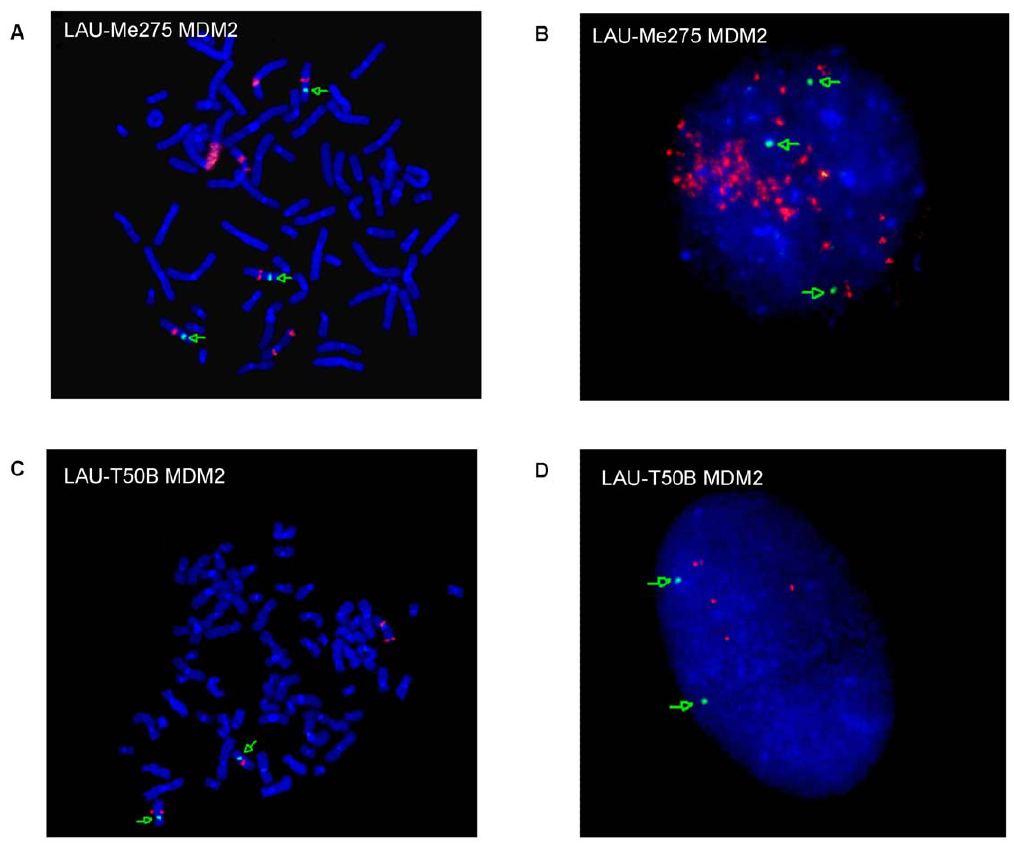
Figure 3. Determination of MDM2 copy number by FISH. The MDM2 gene was assayed in two melanoma samples (LAU-Me275 and LAU-T50B) derived from the same patient. Panels A and C show a metaphase and B and D an interphase. MDM2 probe is in red; centromere-specific probe is in green. FISH shows amplification for both LAU-Me275 (more than eight copies) and LAU-T50B (four copies). Metaphase-FISH helps to identify homogeneously staining regions and Interphase-FISH to estimate the copy number.